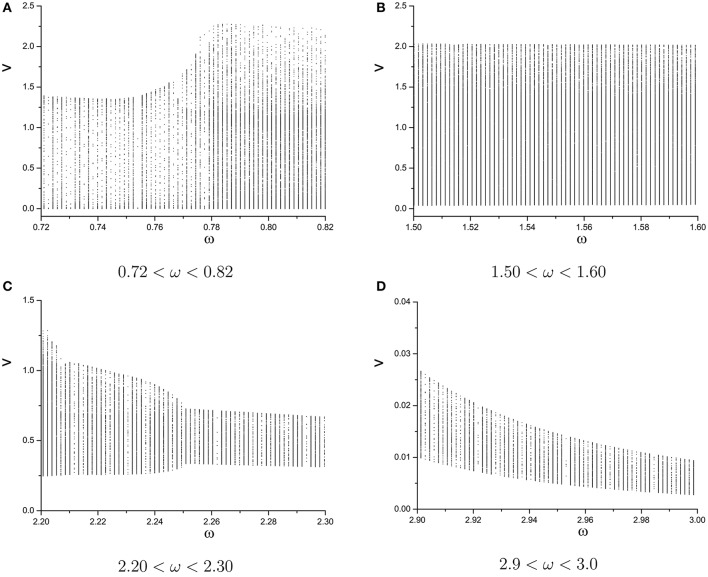
Enlarged views of semi-Poincáre diagram in different ω intervals. (A) 0.72 < ω < 0.82, (B) 1.50 < ω < 1.60, (C) 2.20 < ω < 2.30, and (D) 2.9 < ω < 3.0.